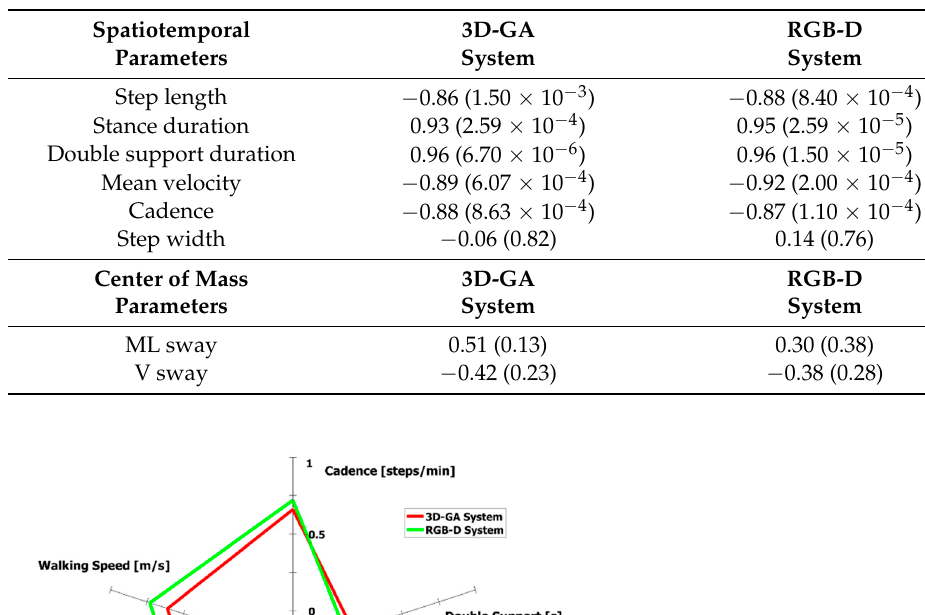
Table 5. Correlation between gait parameters and TUG test: coefficients and p -values of Spearman’s correlation for 3D-GA and RGB-D systems.